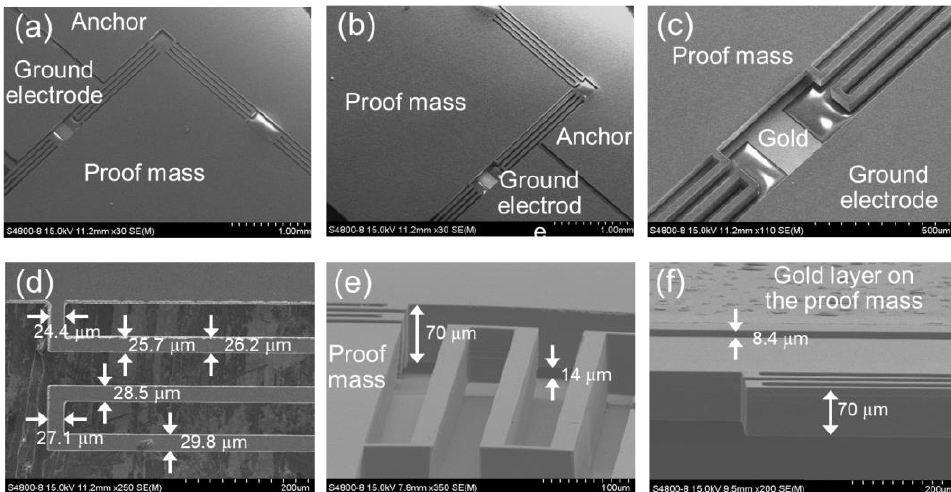
Figure 6. SEM images of the fabricated vertical MEMS actuator. ( a , b ) serpentine spring and anchor part, ( c , d ) close-up view of the serpentine spring part, ( e ) tilt view of the serpentine spring part when the glass substrate is positioned on the bottom side, ( f ) tilt view of the serpentine spring part when the gold layer on the proof mass is positioned on the top side.